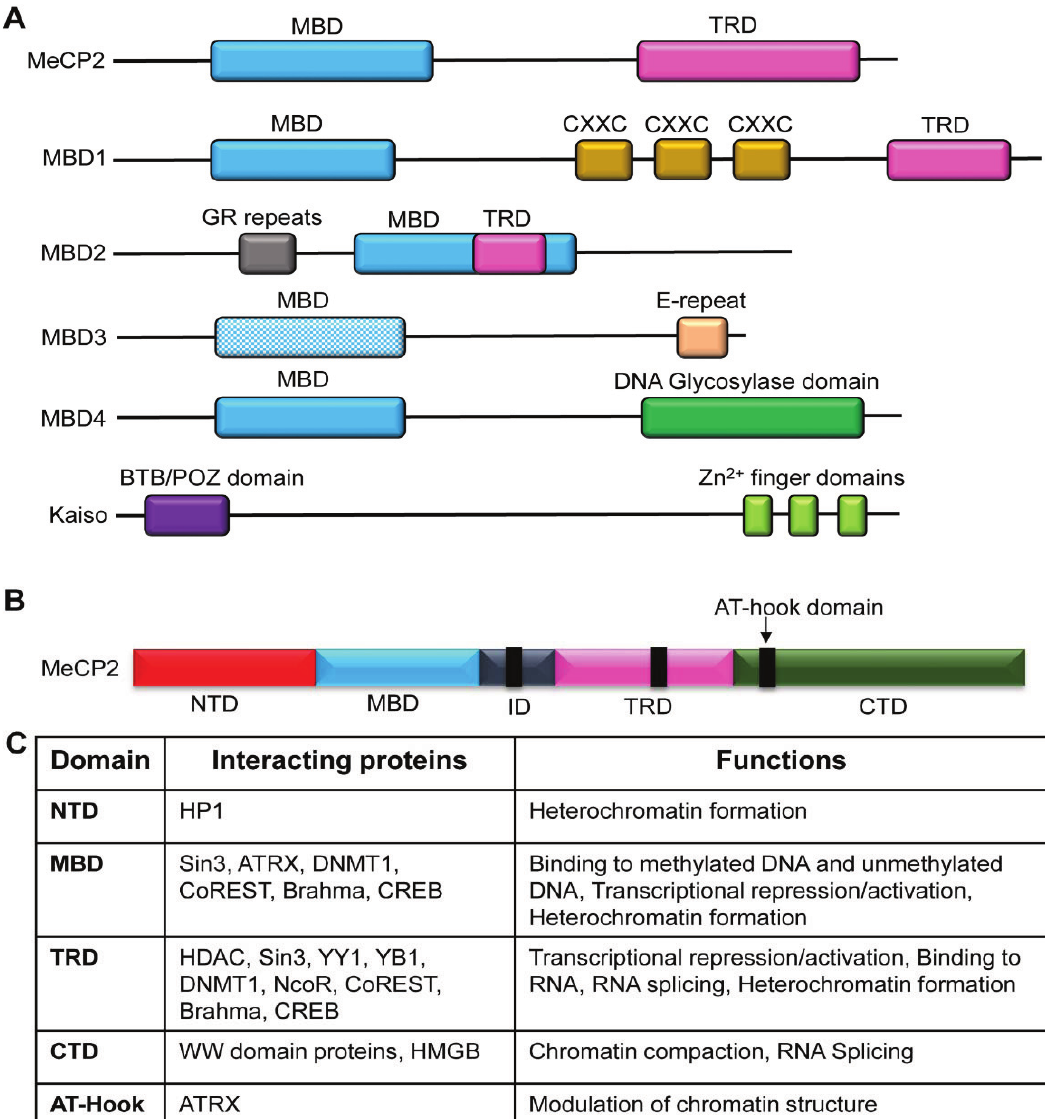
Figure 2. The structure of methyl-CpG-binding protein (MBP) family. ( A ) Comparison of structure of MBPs. The MBP family shares the characteristic methyl-CpG-binding domain (MBD), which enables the recognition and binding to methylated DNA. However, MBD3 is unable to bind to methylated DNA. The transcription repression domain (TRD) is found in MeCP2 and MBD1-2. Apart from MBD, the binding of specific MBDs to DNA can be mediated through CXXC zinc-finger (Zn 2+ ) motifs, glycine and arginine residues (GR), and thymine glycosylase. The Kaiso family of proteins is characterized by a BTB/POZ domain and a triple zinc-finger domain. ( B ) Domains of MeCP2. Apart from the characteristic MBD, there are other domains, which are important in protein interactions and functions.